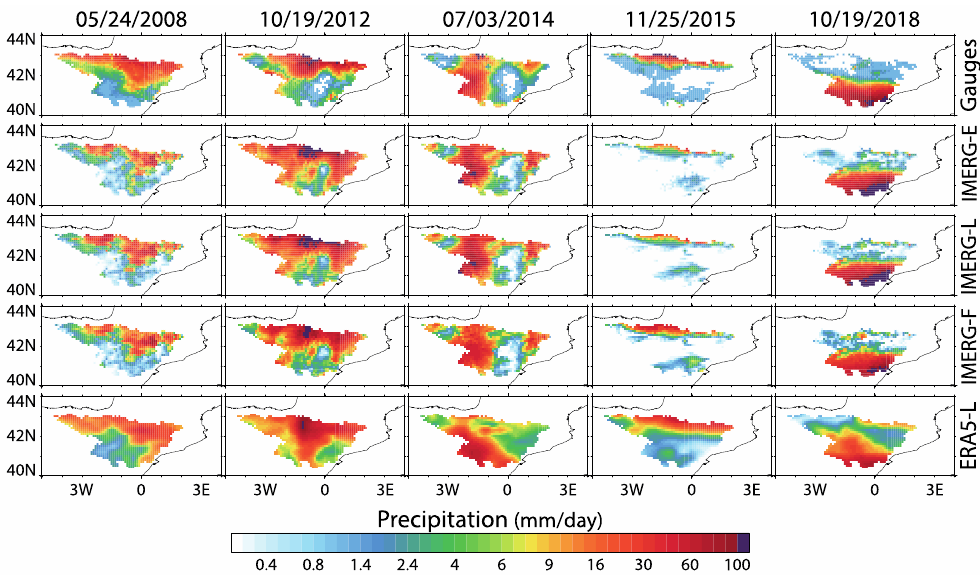
Figure 4. Comparison of 24-h accumulated precipitation for five selected cases and five datasets: Gauges (first row), IMERG (second to fourth rows), and ERA5 (fifth row). Remote Sens. 2020 , 12 , x FOR PEER REVIEW